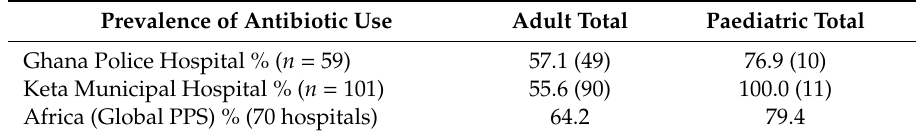
Table 1. Prevalence of antibiotic use in Ghana hospitals compared with Africa data from Global PPS.